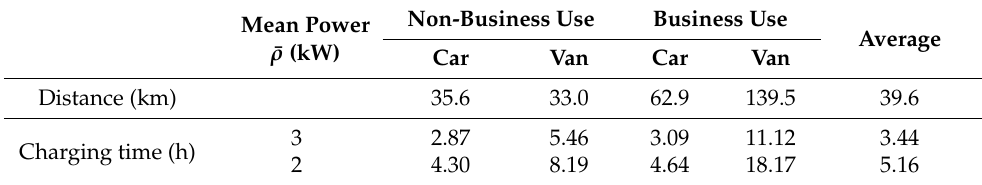
Table 8. Charging time per day (lower mean fuel efficiency α = 4.04 km/kWh and η = 0.95). Mean Power ¯ ρ